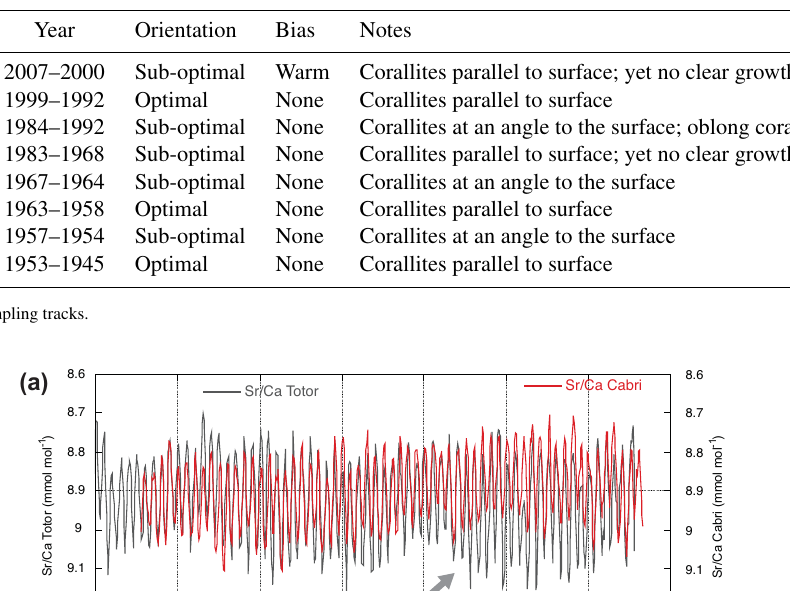
Table 3. Summary of sampling issues detected in core Cabri.